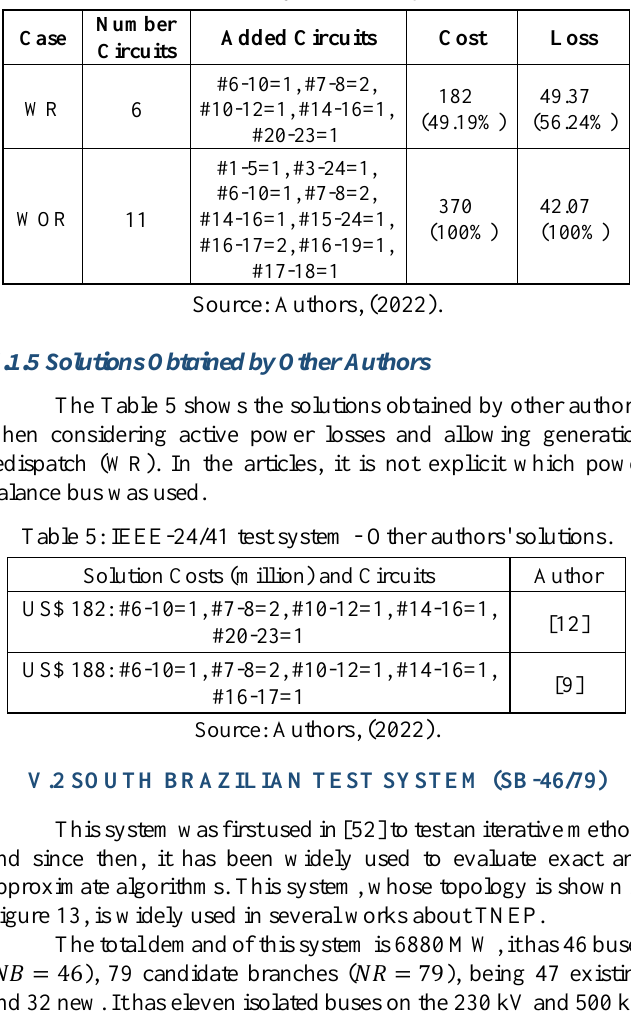
Table 4: IEEE-24/41 test system - Comparison of the cases.